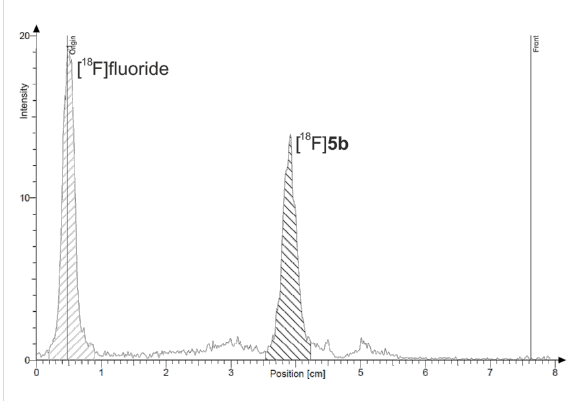
Figure 8: Radio-TLC (eluent: ethanol) of [ 18 F] 5b ( R f = 0.50; reaction mixture).